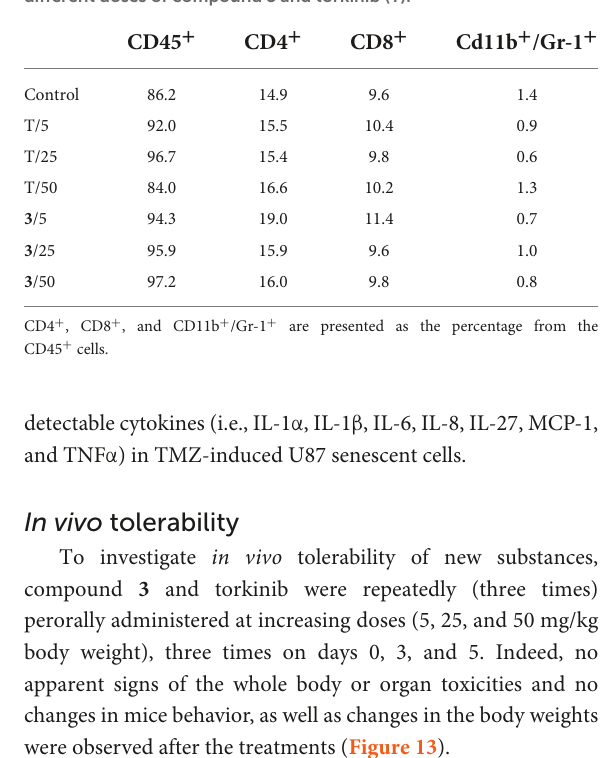
Frontiers in Aging